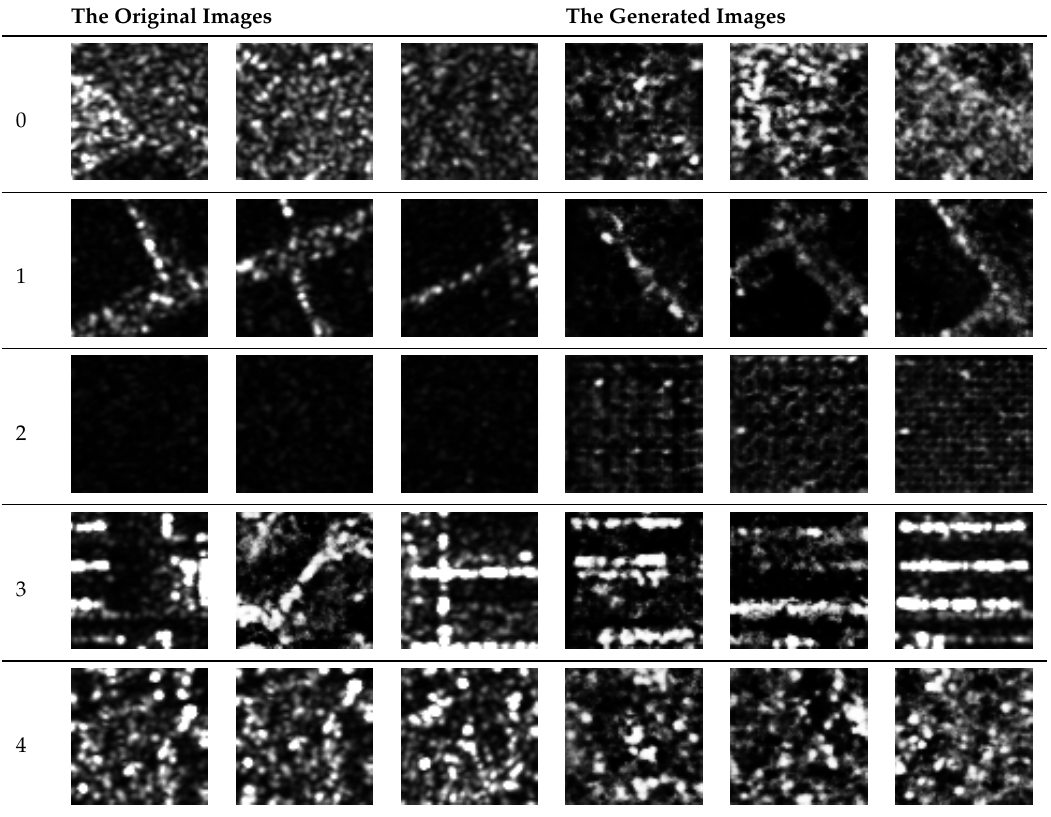
Table 4. DataSet2: The original images and the images generated by